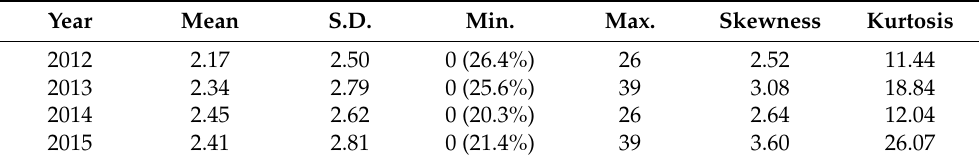
Table 1. Descriptive statistics of annual domestic travel